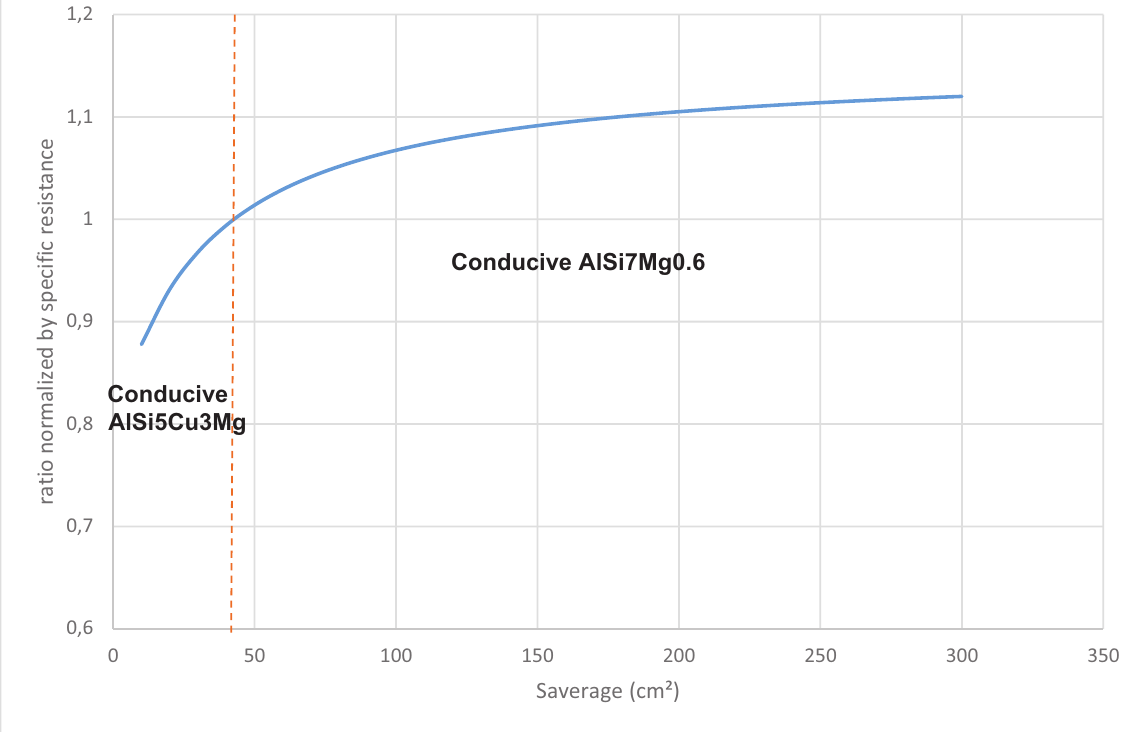
Fig. 18. “ Pro fi tability ” region of the AlSi7Mg0.6 and AlSi5Cu3Mg